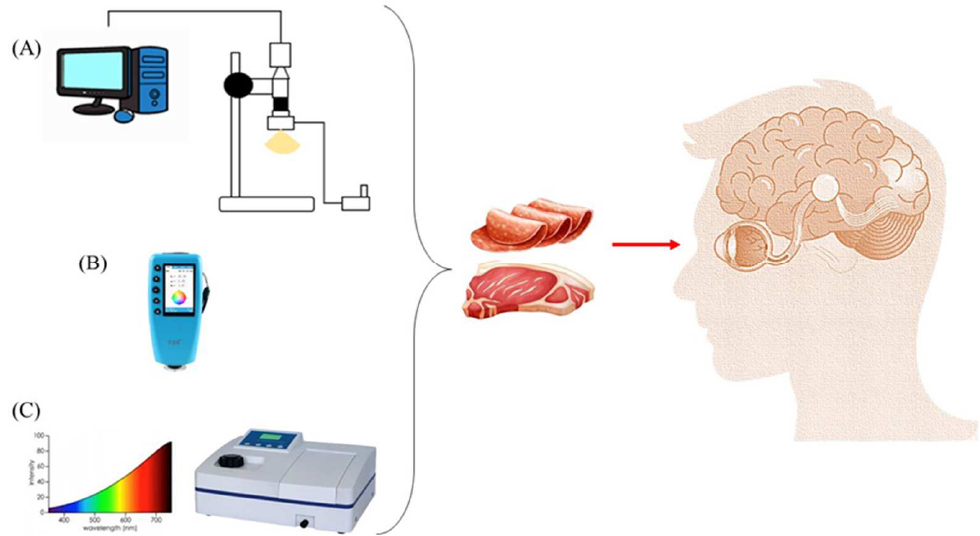
Figure 2. E-eye’s Operating System: ( A ) Computer Vision, ( B ) Colorimeter, ( C )